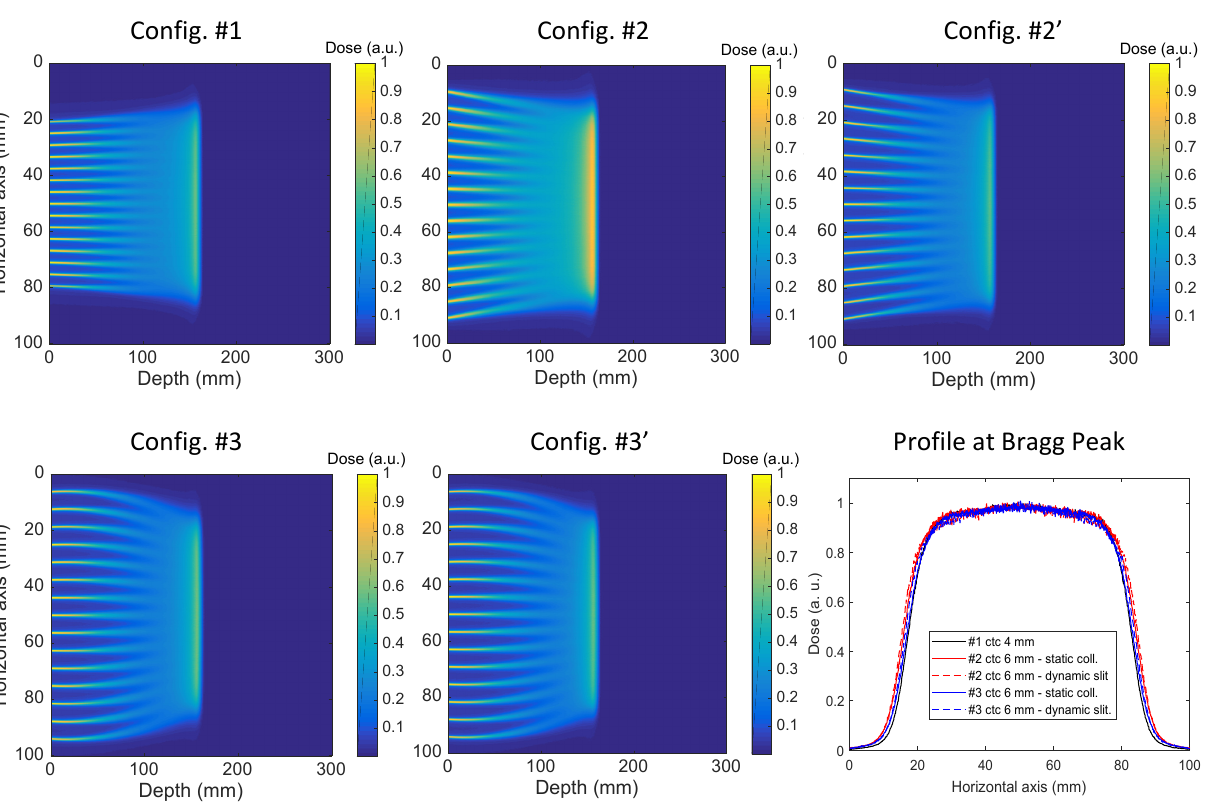
Figure 2. Dose maps for a 150 MeV beam in the five analyzed configurations and the corresponding transverse profiles at the Bragg peak (bottom-right figure).